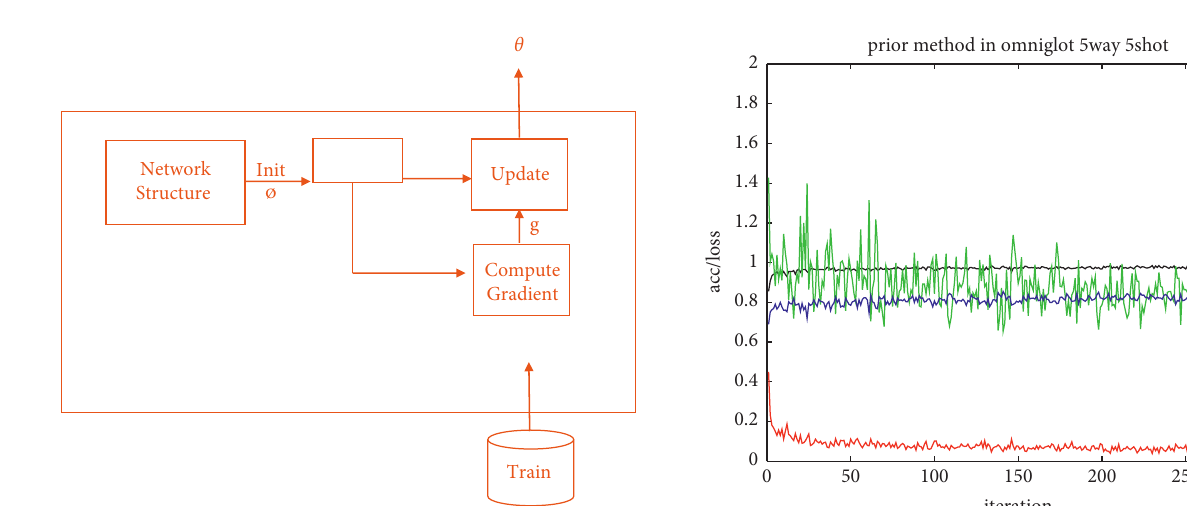
Figure 4: Simplified heredity: one update is enough for finding a gene.